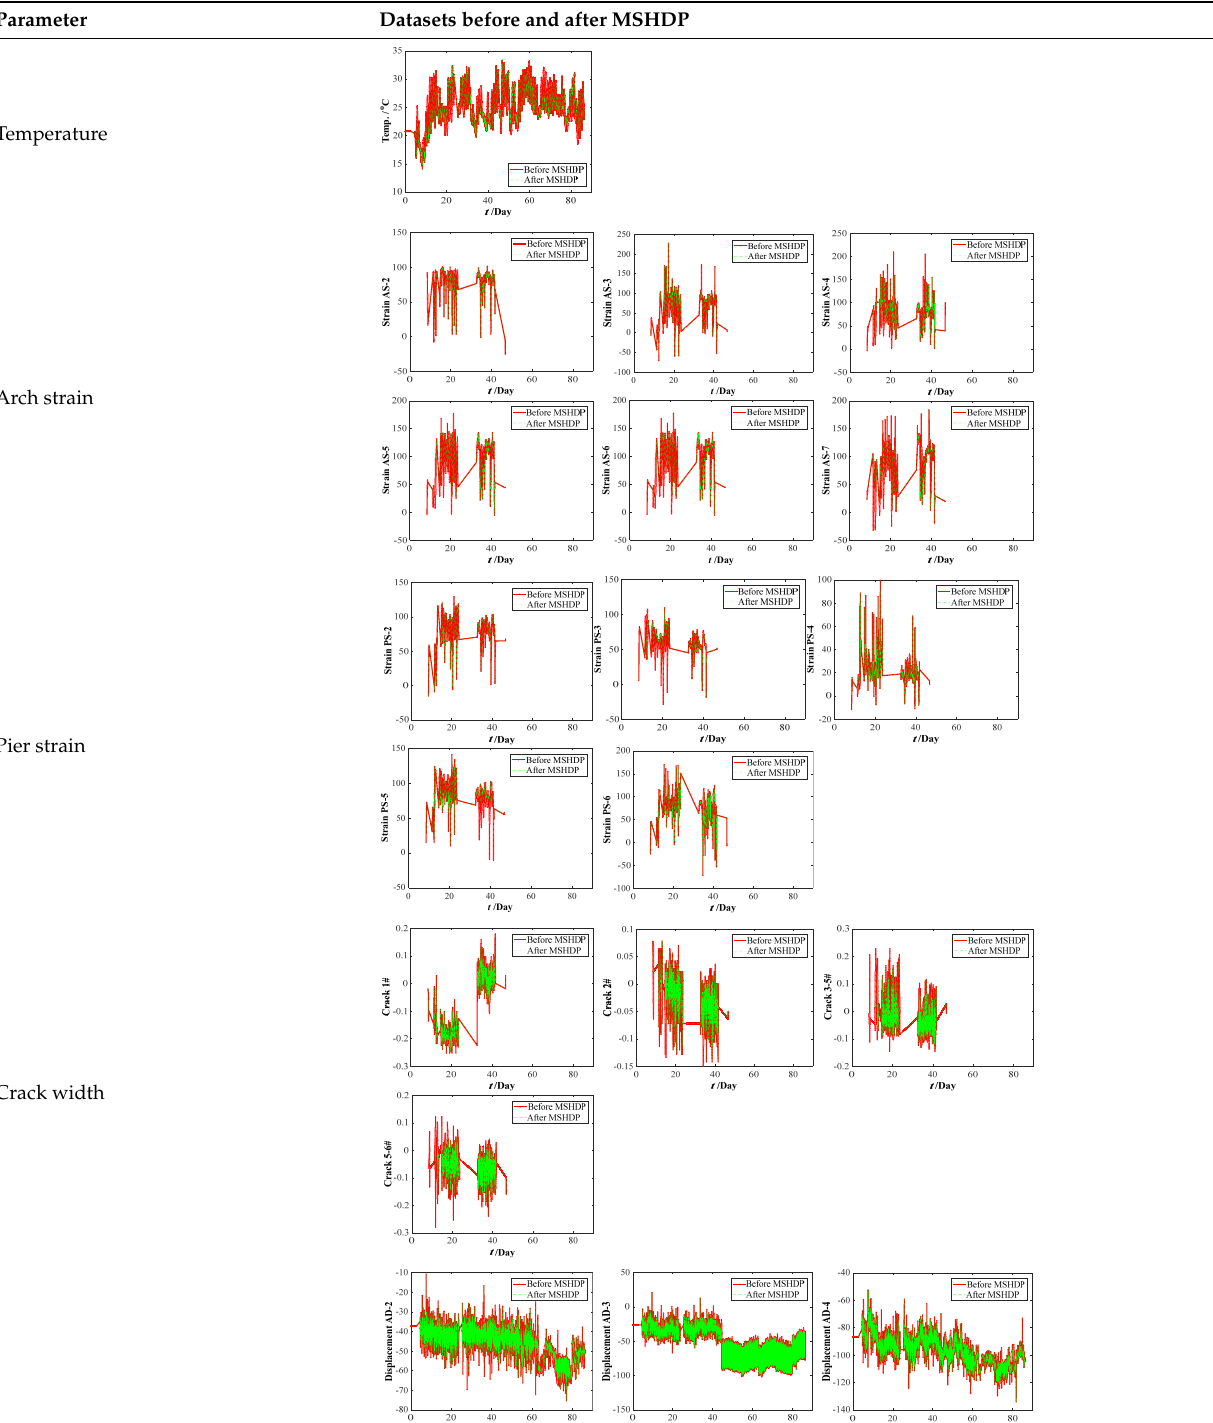
Table 9. Original datasets before and after MSHDP.